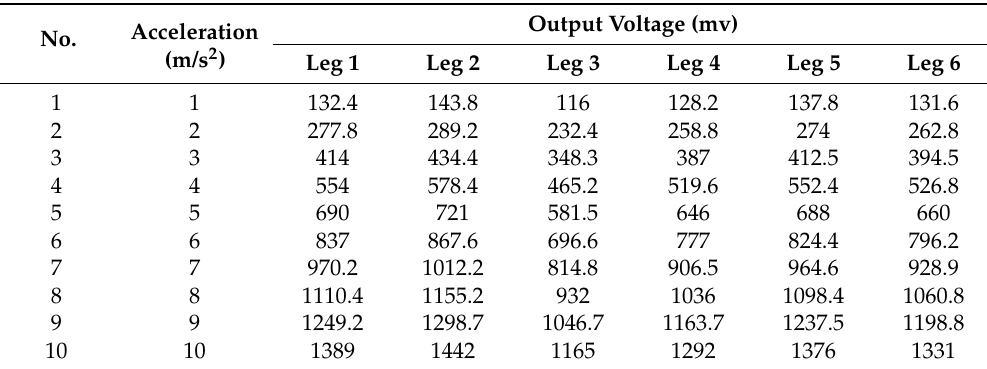
Table 3. Output voltage of each channel on z -axis acceleration.